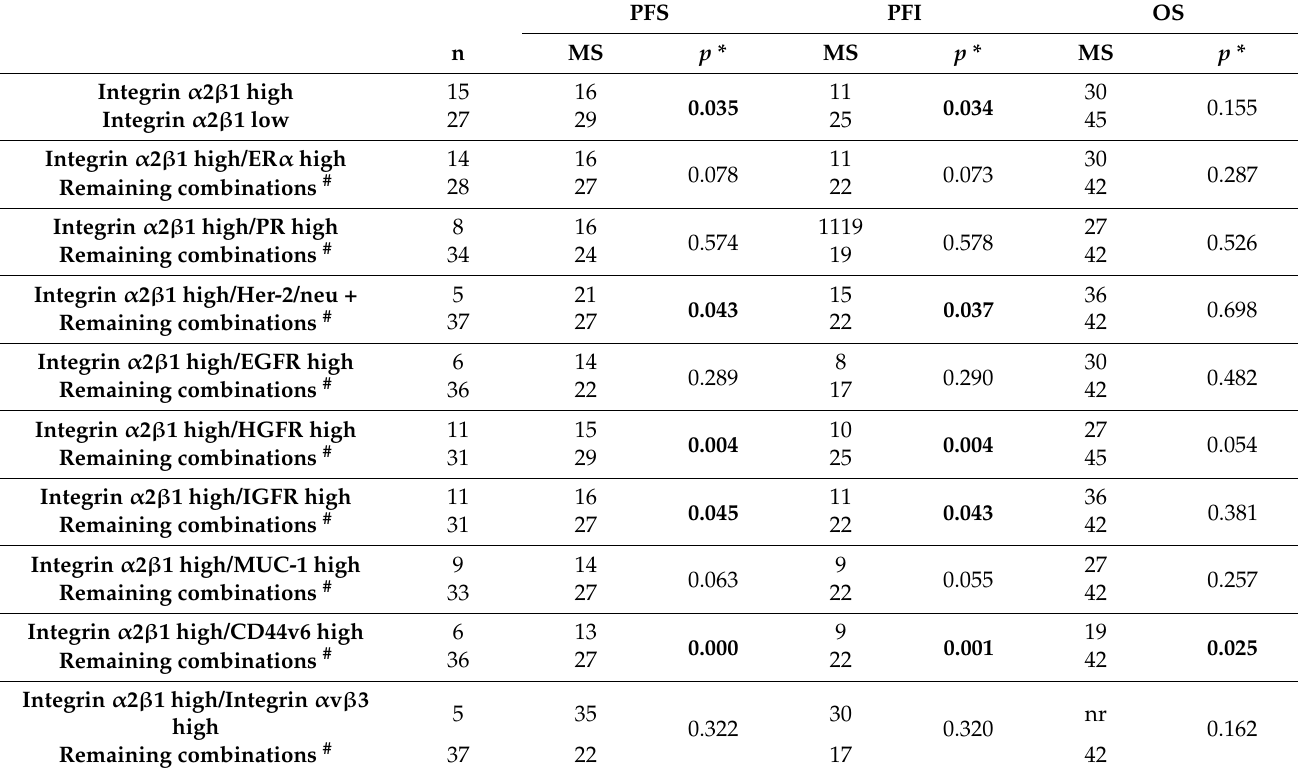
Table 5. Univariate survival analysis of dual expression of integrin α 2 β 1 and other